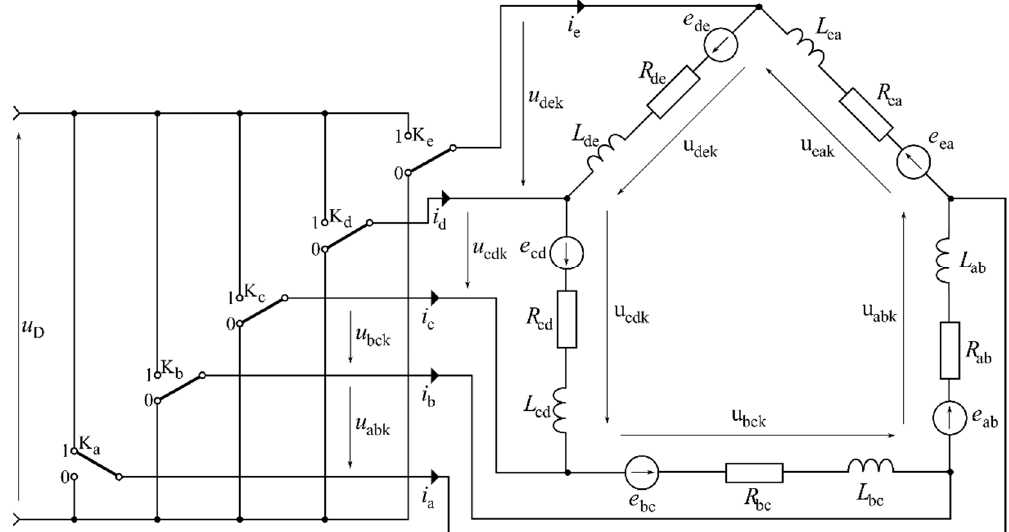
Figure 3. The model of the five-phase two-level inverter with the pentagon connected load according to the state vector 𝑉 16(10000) .